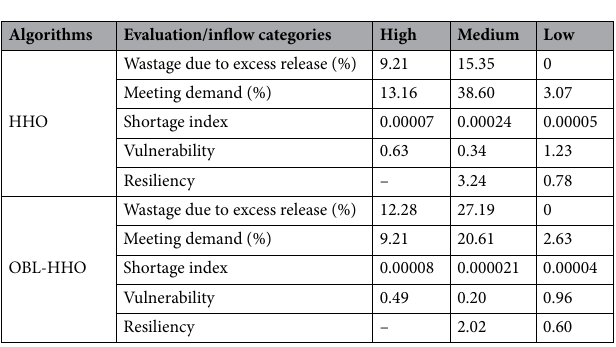
Table 4. Performance evaluation of the HHO model from the year 2001–2019